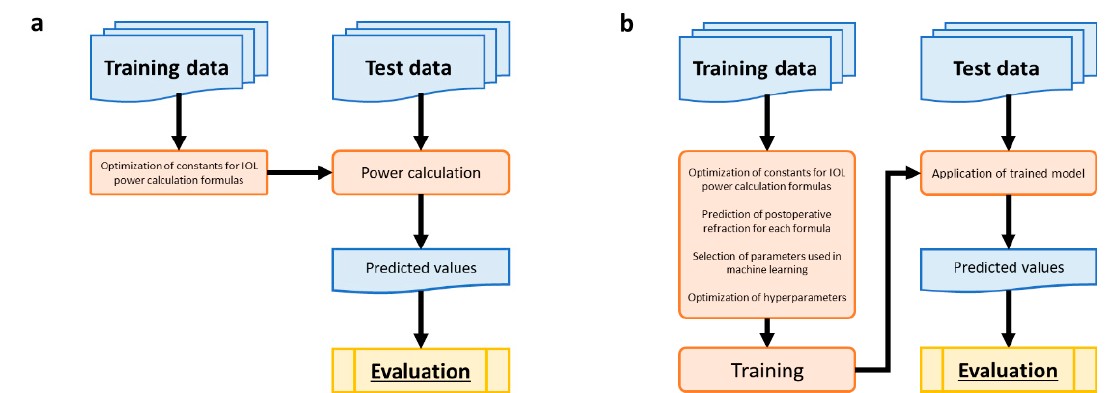
Figure 1. ( a ) Flow of prediction using the conventional intraocular lens (IOL) calculation formulas. ( b ) Flow of prediction using machine learning methods. Figure 1 Summary of the training and test